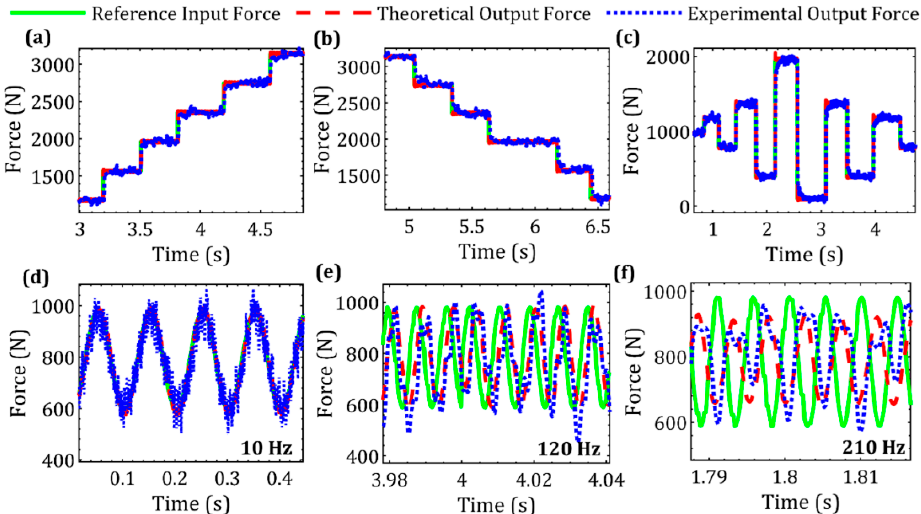
Figure 23. Theoretically predicted and experimental force response: ( a – c ) increasing, decreasing, and random step load, respectively; ( d – f ) sine load with 785 N static and ± 196 N dynamic force at 10 Hz, 120 Hz and 210 Hz, respectively.